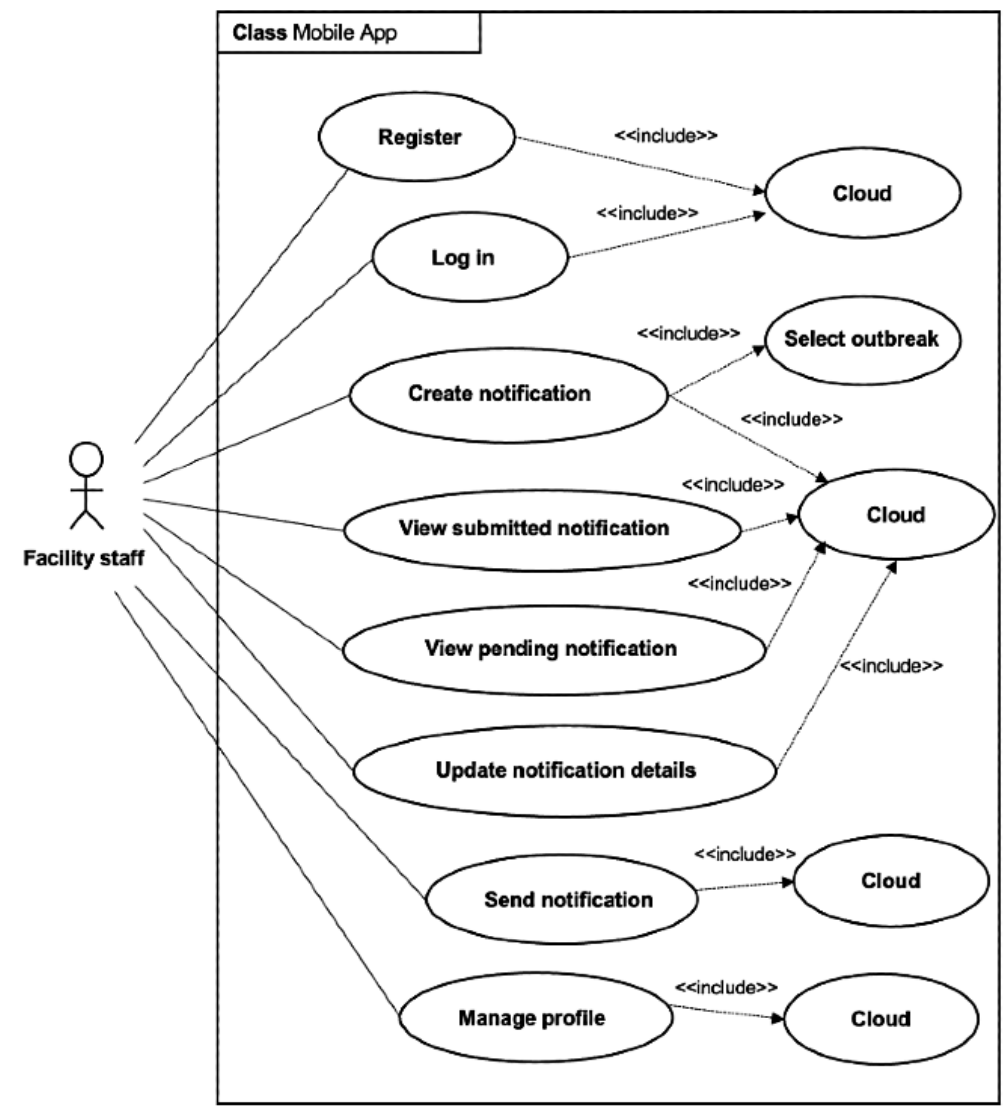
Figure 3. Use case diagram for the system (mobile app).